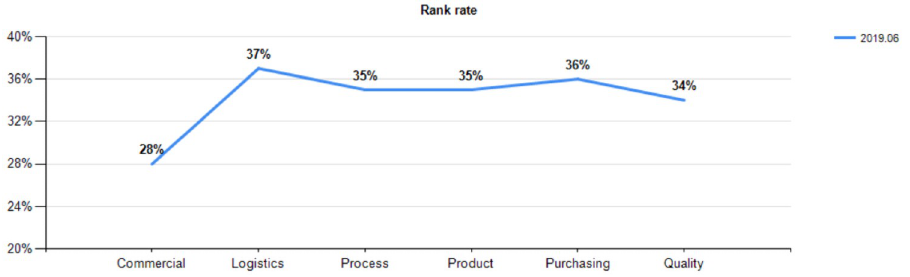
Fig 5. Efficiency ratio of post functions to tasks